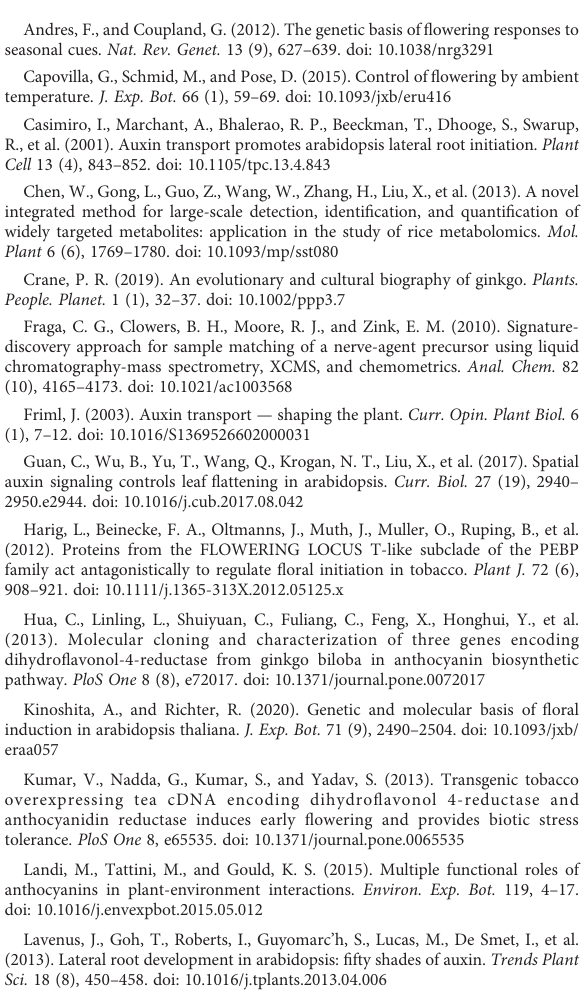
SUPPLEMENTARY TABLE 3 Upregulated and downregulated fl avonoid compounds detected